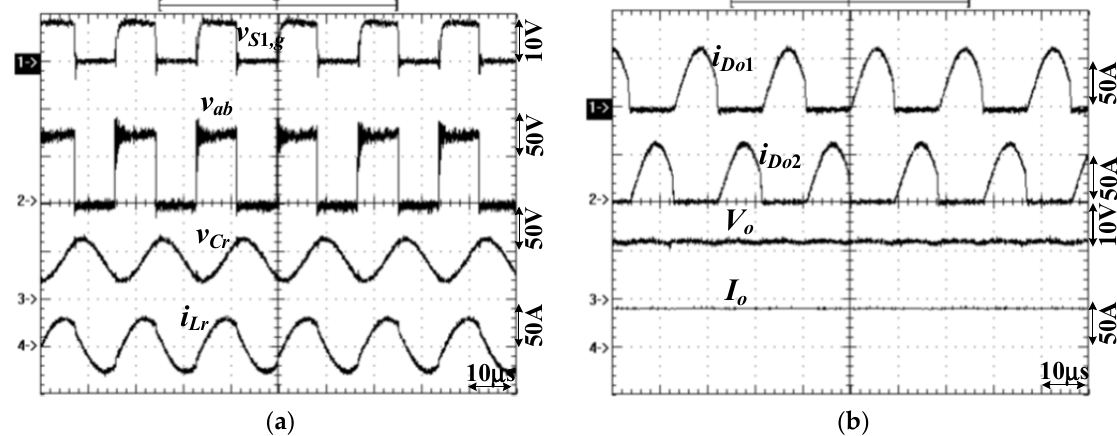
Figure 11. Measured results at V in = 74 V and P o = 500 W ( a ) v S 1, g , v ab , v Cr and i Lr ( b ) i Do 1 , i Do 2 , V o and I o .